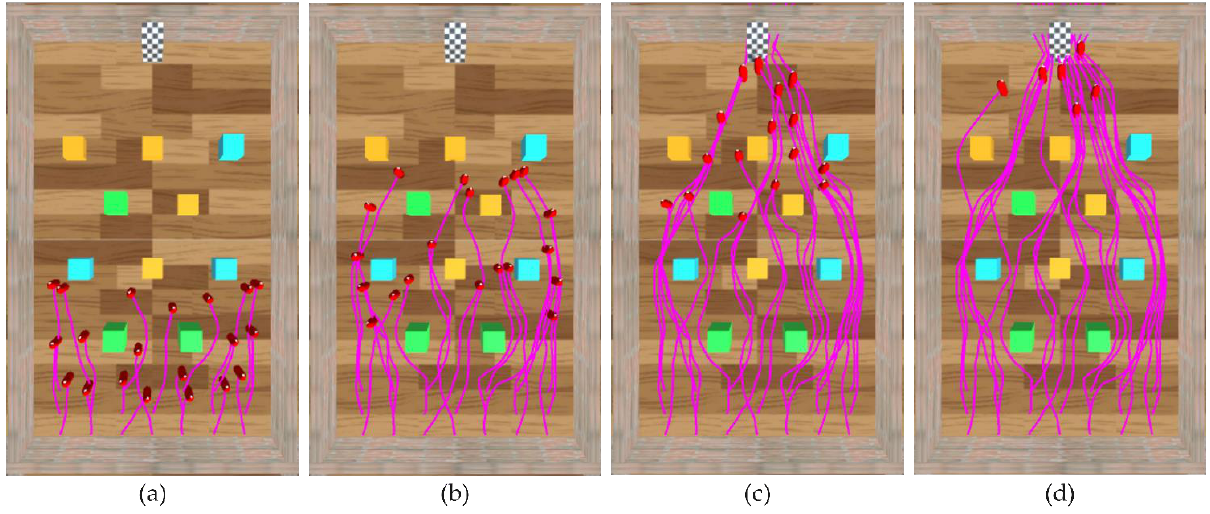
Figure 10. A temporal sequence of an experimental result generated by HDRLM3D in scenario II. ( a – d ) Stills of the experimental result. The temporal sequence of these stills is sorted alphabetically.